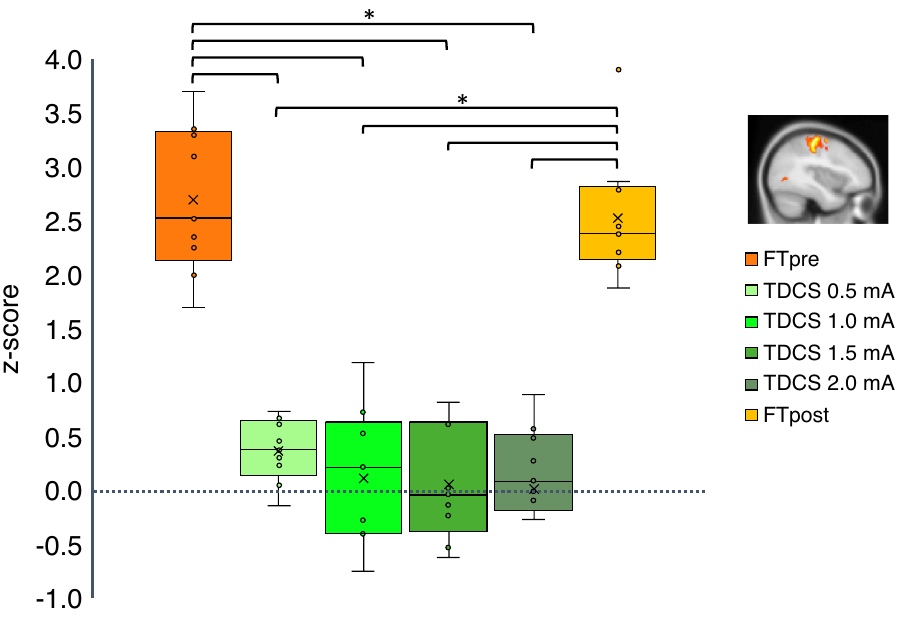
Figure 2. Change in regional cerebral blood flow in left primary motor cortex. The region is defined corresponding to the regional activation during the finger-tapping task prior to stimulation (FTpre) as shown red colors in Fig. 1. Box and whisker plot of activation during TDCS at 0.5–2.0 mA (green shades) and finger- tapping before stimulation (FTpre) and after (FTpost) (orange shades). Y-axis shows activation in z-score. Outliers defined being beyond 1.5 inter-quartile range of each